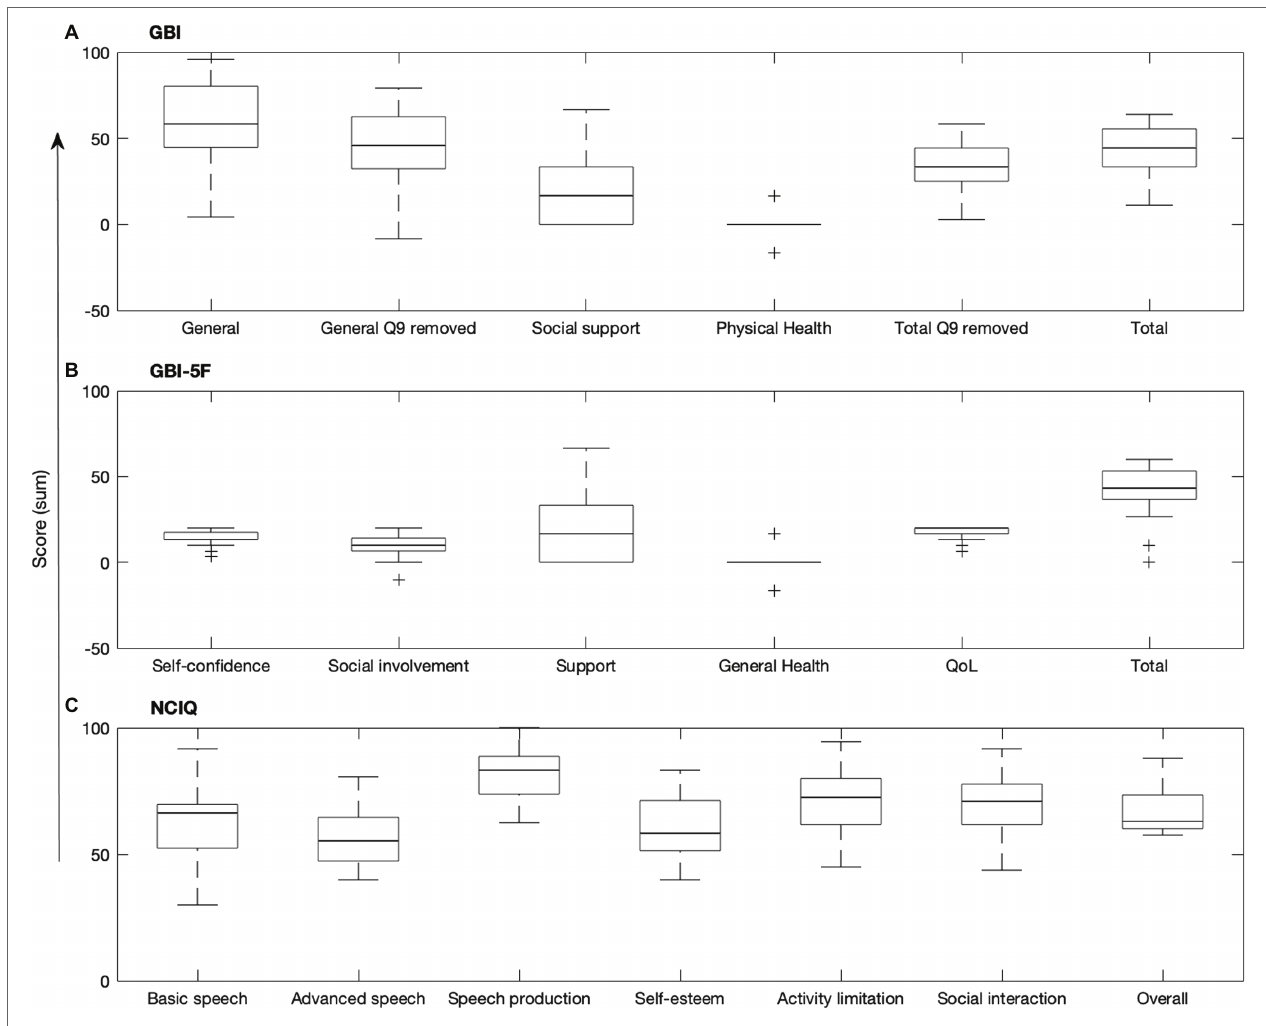
FIGURE 1 | Boxplots of the (A) GBI, (B) GBI-5F, and (C) NCIQ. Central mark indicates median, bottom and top edges of box indicate 25th and 75th percentiles, whiskers extend to minimum and maximum points, and plus signs indicate outliers. Q9, question 9